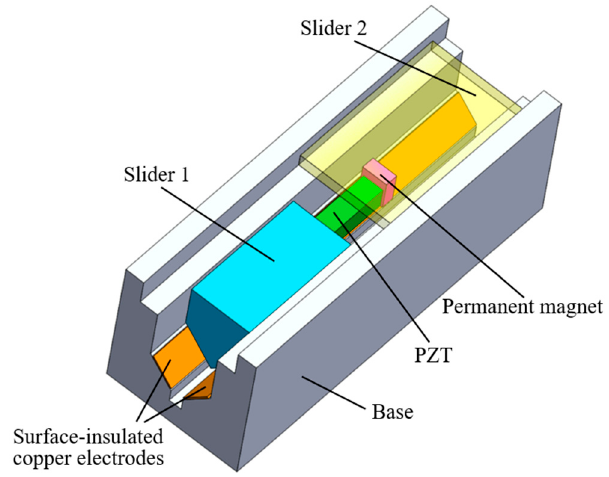
Figure 1. Configuration of the dual-slider linear actuator.